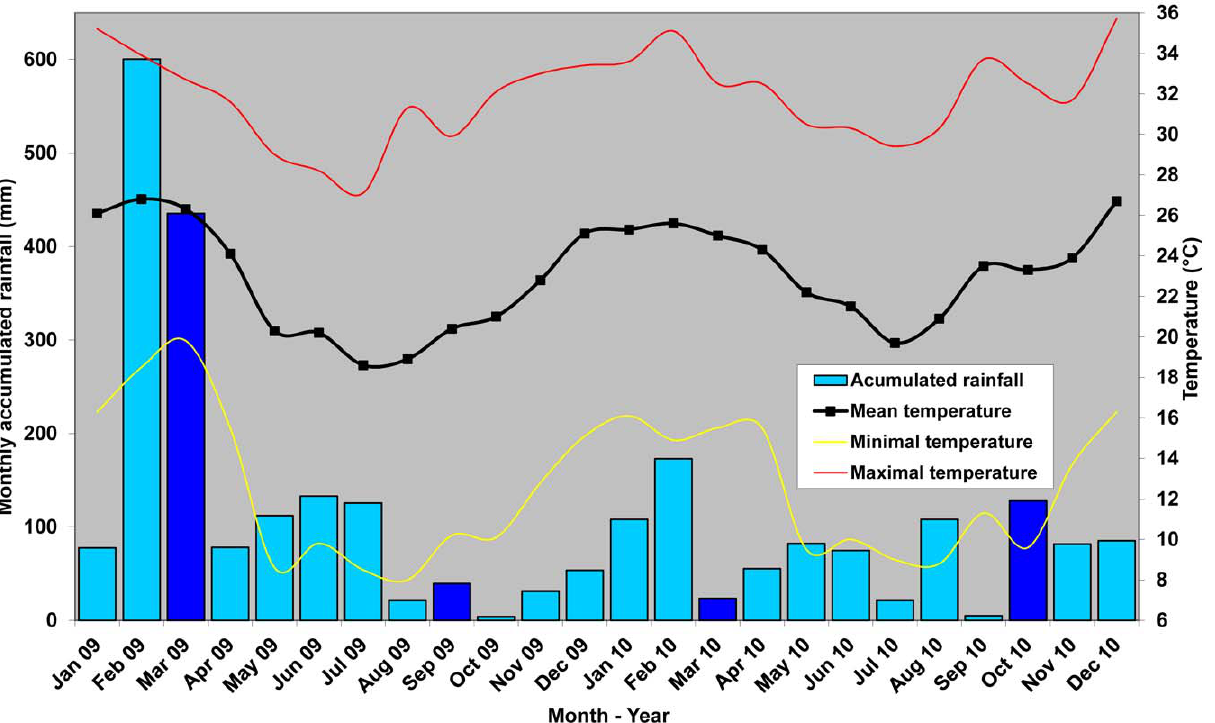
Figure 3. Meteorological data during the two years of the survey (data kindly provided by Me´te´o France). The rainfall bars of our sampling months appear deeper blue.